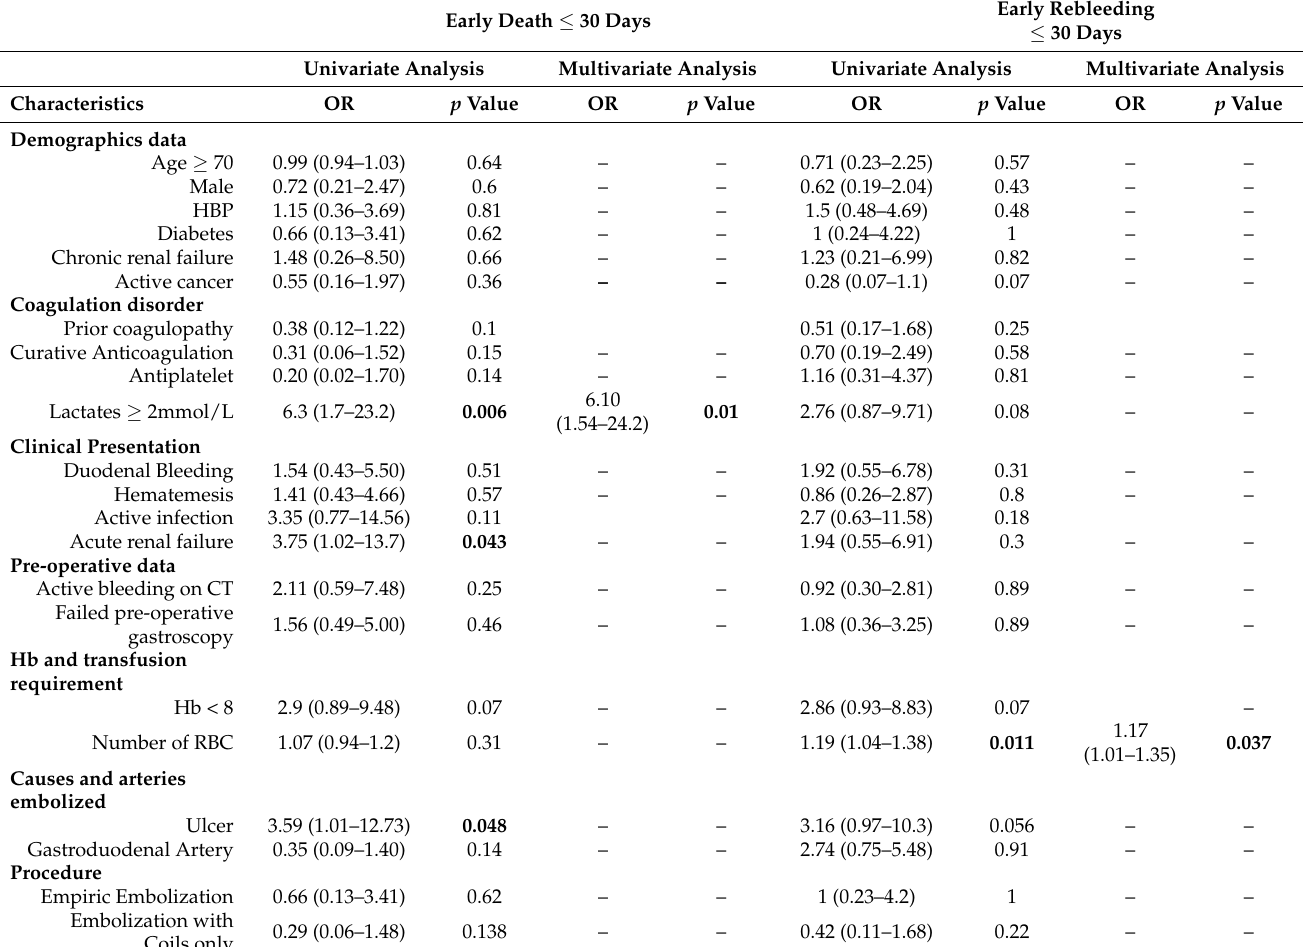
Table 5. Univariate and multivariate regression analysis for early death and early